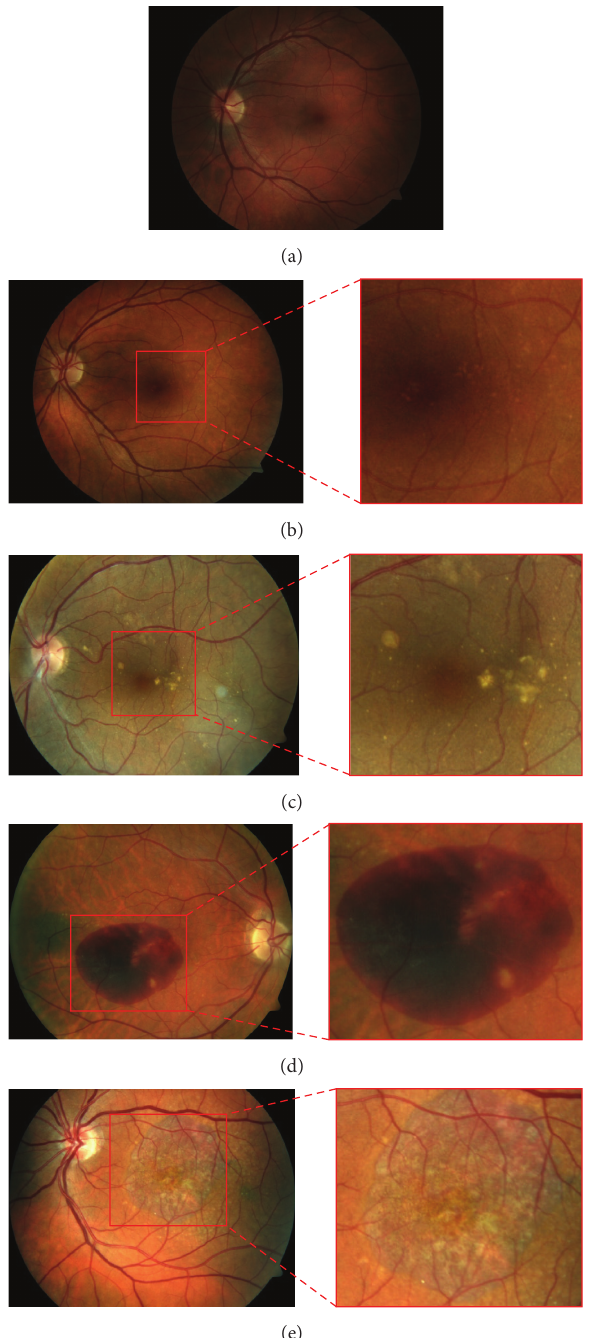
Figure 1: Images of macula area for different AMD categories: (a) healthy case in category {1} , (b) category {2} with hard drusen, (c) category {3} with soft drusen, and (d) category {4} with hemorrhages and (e) with geographic